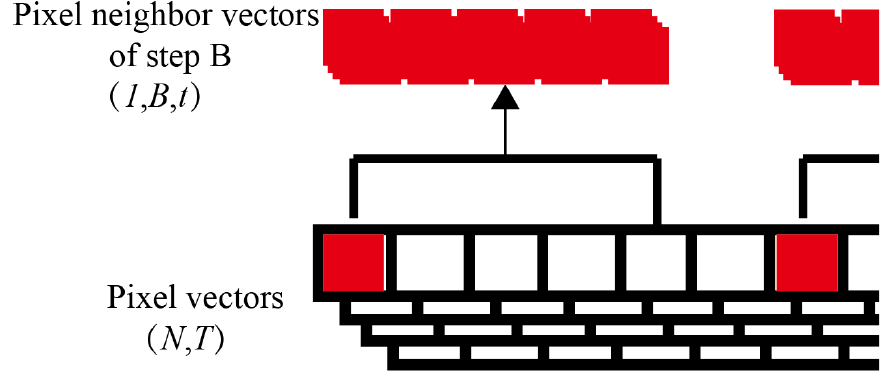
Figure 4. Input resampling workflow. The double-attention RNN resamples the input pixel vectors with step B to enlarge the analyzing dimensions of the feature extraction to the temporal and pixel neighbor domains. The black grids represent N pixels in T time phases and the two red grids at the bottom of the figure are pixels to be resampled; the red pixel vectors on top of the figure are the resampled feature vectors with step B .